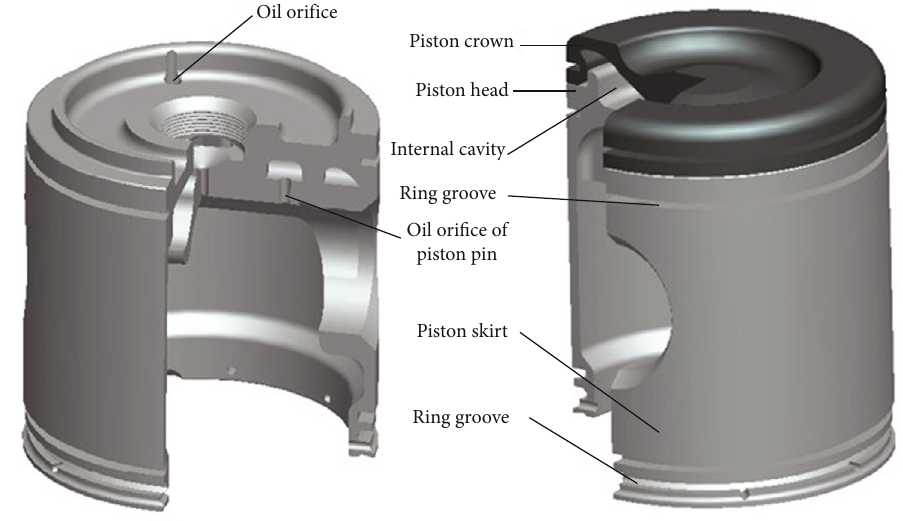
Figure 1: Internal structure of the combined